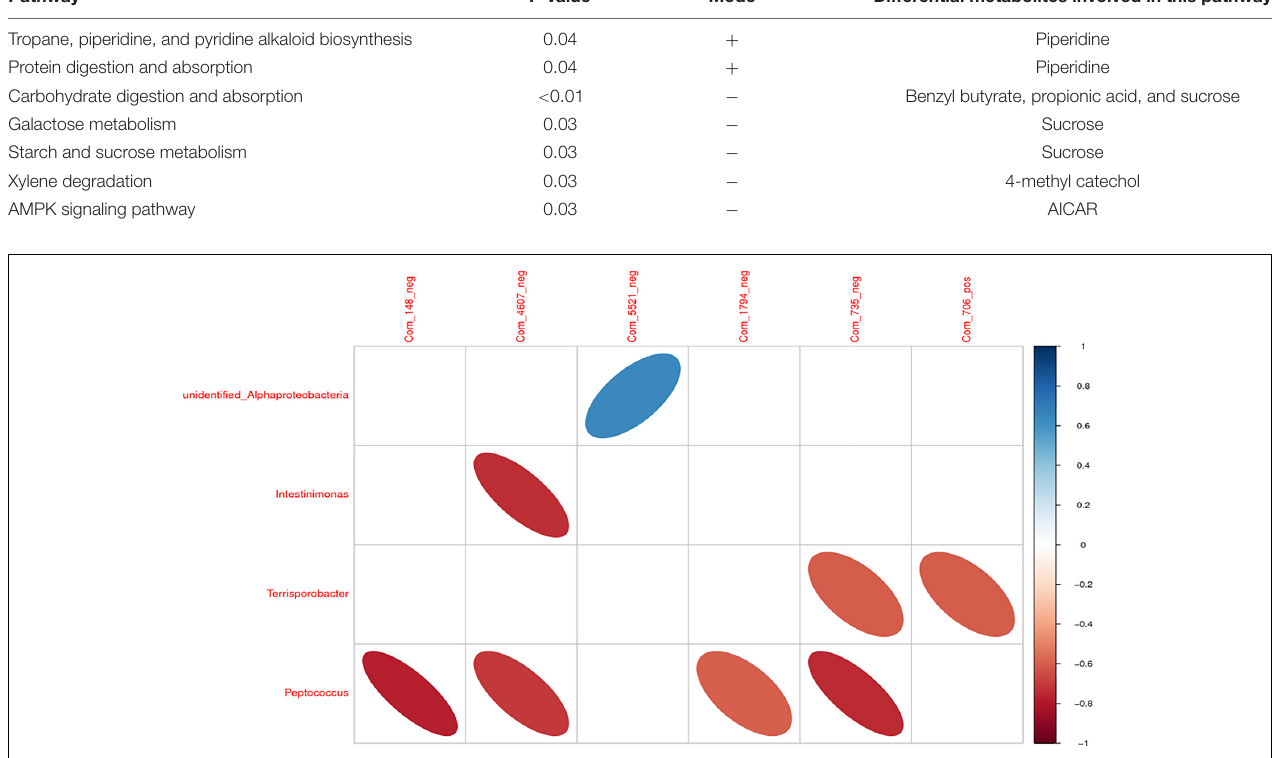
FIGURE 11 | The correlation heat map of differential intestinal microbiota and metabolites. Note: Com_148_neg: propionic acid; Com_4607_neg: benzyl butyrate; Com_5521_neg: sucrose; Com_1794_neg: AICAR; Com_735_neg: 4-methyl catechol; Com_706_pos: piperidine.